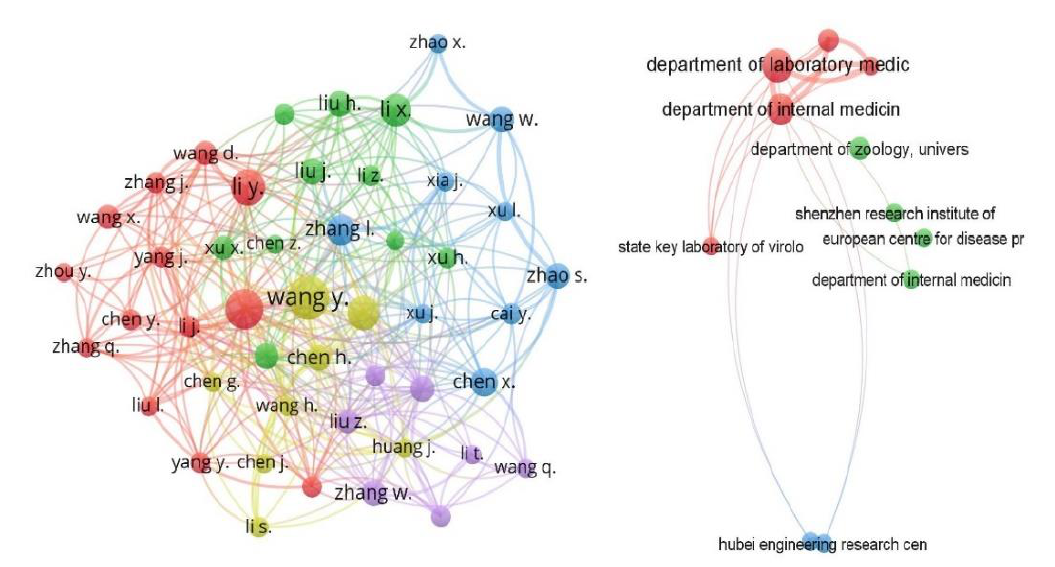
Figure 4. Network visualisation between the contributed authors & institutes in the field of COVID-19 by VOSviewer